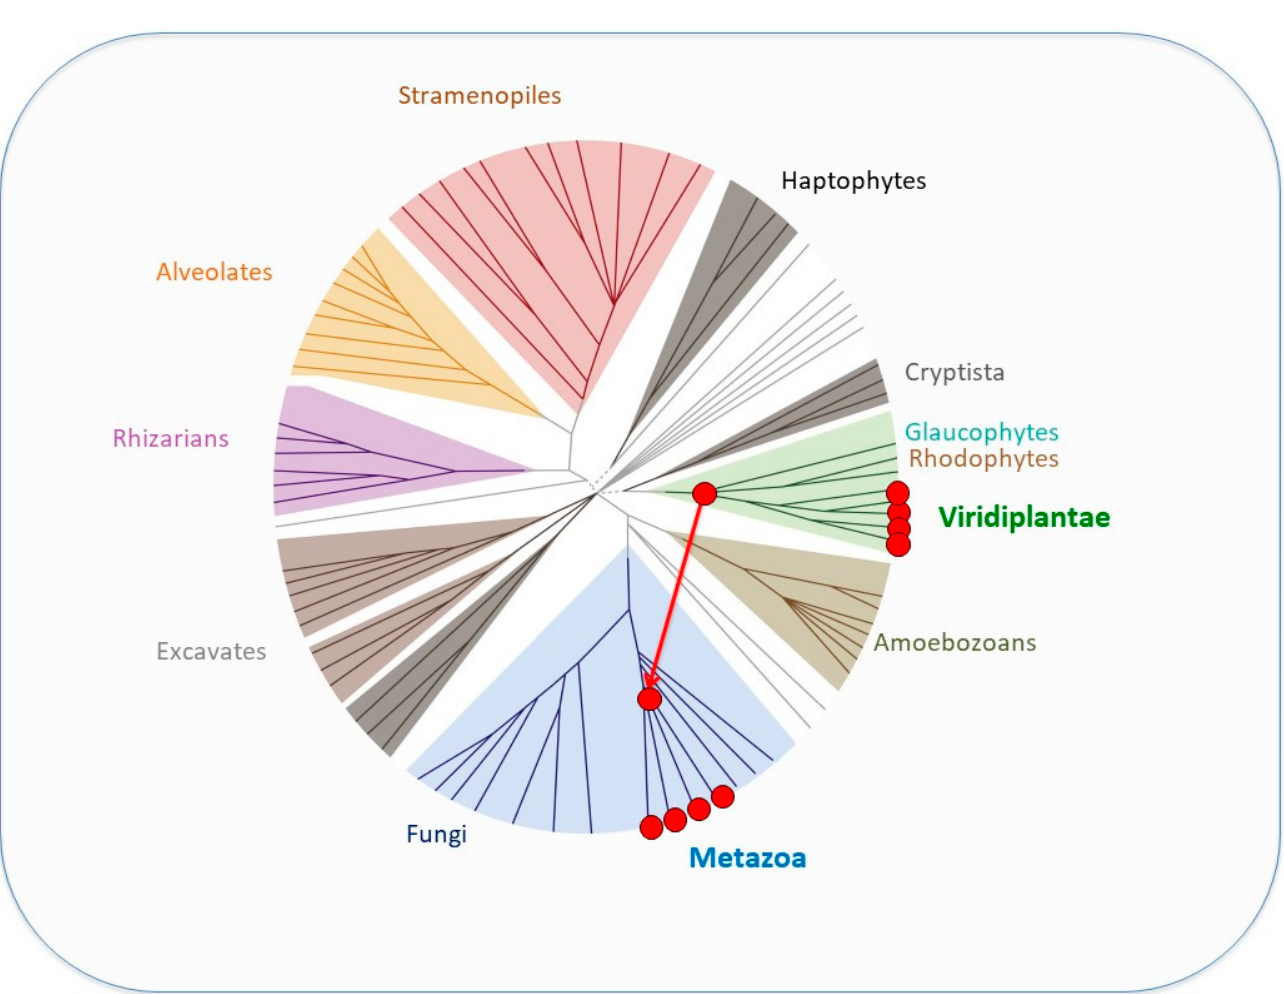
Figure 7. Unrooted eukaryotic tree (adapted from the study by Keeling & Burki [75]) showing the phylogenetic distribution of SAND sequences (red dots indicate occurrence and the hypothesized lateral gene transfer (red arrow) from a green algal ancestor to an early metazoan (adapted from [71]). For further discussion on the postulated lateral gene transfer, see the study by Nedelcu [71].